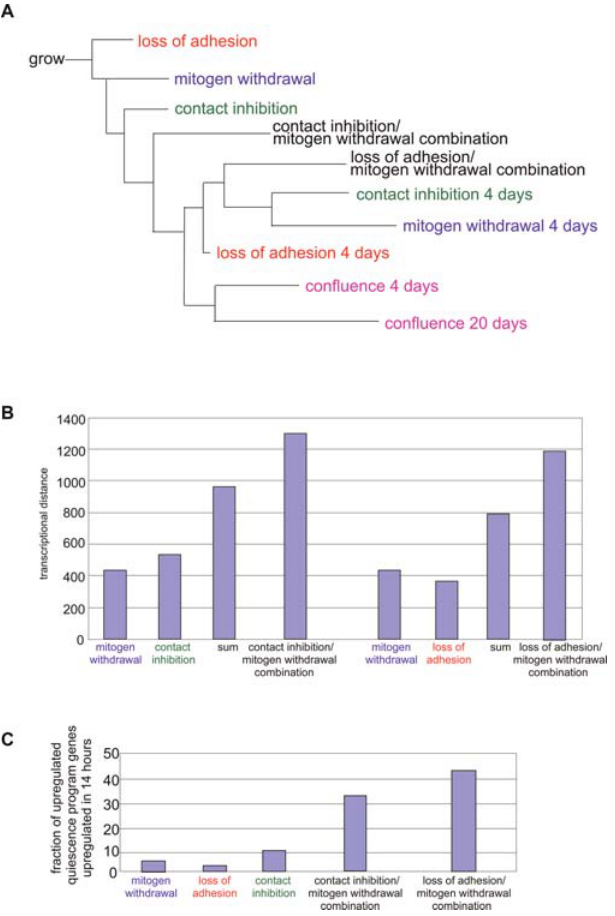
Figure 6. Combination of Arrest Signals Results in Synergistic Effects (A) Neighbor-joining tree defining the relationship among growing cells, cells arrested by a single signal overnight, by a combination of signals, by single signals for 4 d and by longer arrest. Transcriptional distances (Genechip suite 4.0) were determined and the mean transcriptional distances for the two examples of each arrest condition were used to construct the distance matrix and neighbor-joining tree. (B) Mean transcriptional distance from growing cells to cells arrested by individual signals overnight, and the sum of the distances, is plotted, and compared with the transcriptional distance from growing cells to cells arrested overnight by a combination of signals. (C) The fraction of upregulated quiescence program genes that were upregulated by each individual signal and by combinations of signals after an overnight arrest. DOI: